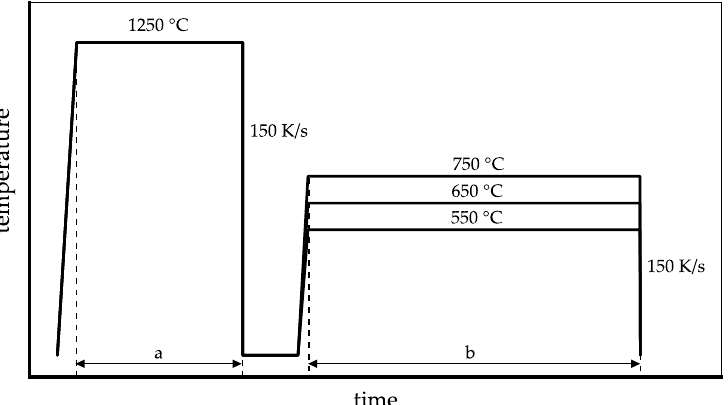
Figure 1. Temperature and holding times (a=1h; b=0.5, 1, 2, 4, 6, 8, 12, 24, 48, 96, and 192h) for the applied heat